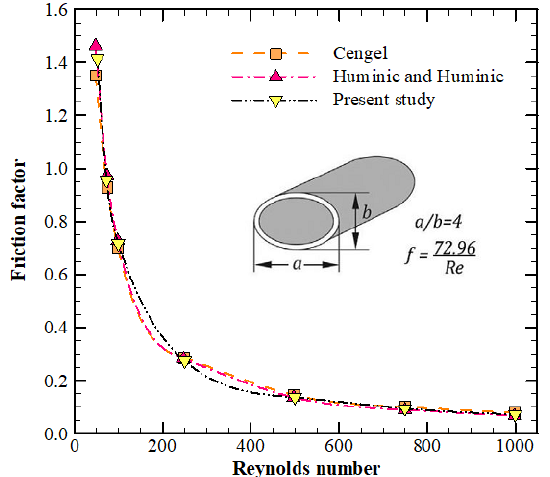
Figure 4. Average friction factor versus Reynolds number: comparison between the present results and those reported by Cengel [56] and Huminic and Huminic